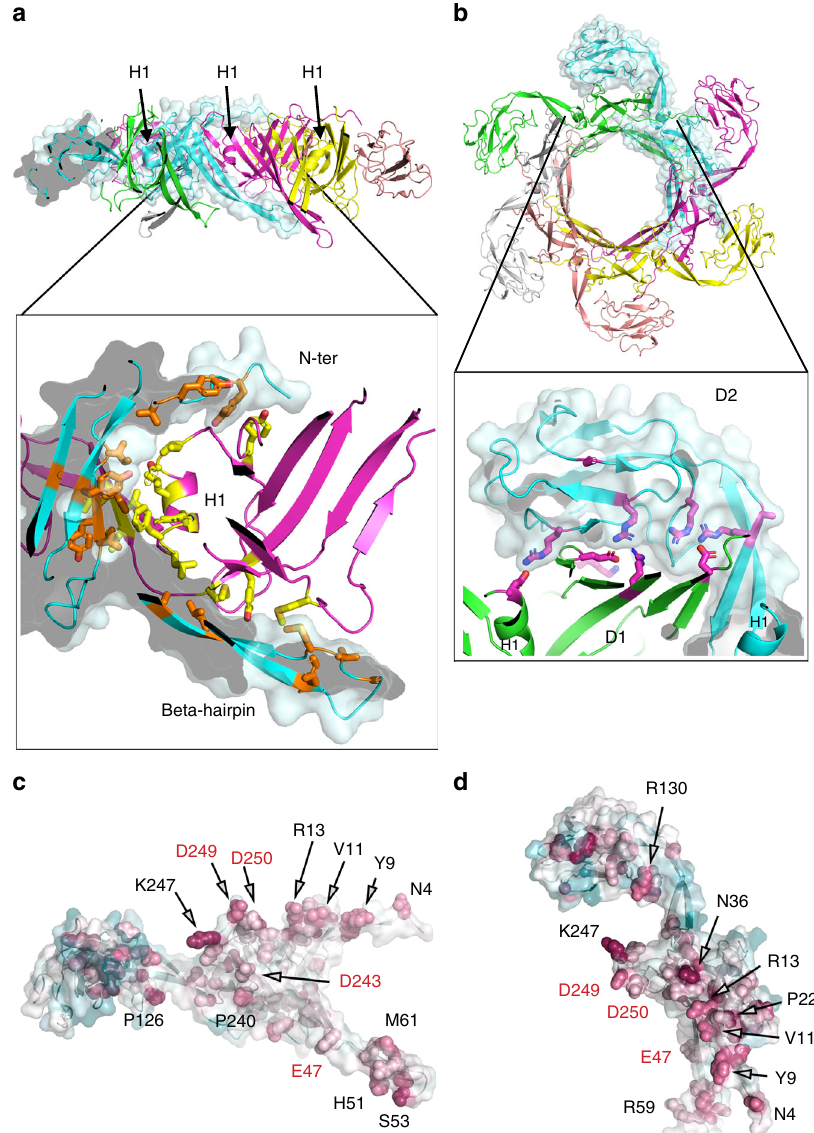
Fig. 6 The tail tube is stabilised by extensive contacts within the hexameric ring of YSD1_22. a The hexameric ring of the tail-tube protein is shown from the side with H1 helices indicated. In the inset, hydrophobic and aromatic residues within 4 Å of the neighbouring subunit are shown as sticks and their carbon atoms are coloured in yellow and orange. For clarity, only two subunits are represented in the zoomed view. b Axial view of the hexameric ring. The inset shows a zoomed view of the interface between D1 and D2. Charged residues within 5 Å of the neighbouring subunit are shown as sticks and their carbon atoms are coloured in magenta. c , d Same views as the cyan molecule in a and b . Low-to-high sequence conservation as calculated by the ConSurf server is mapped onto the molecular surface with a cyan – white – red gradient. Side chains of the most conserved residues are shown as spheres. Acidic residues are labelled in